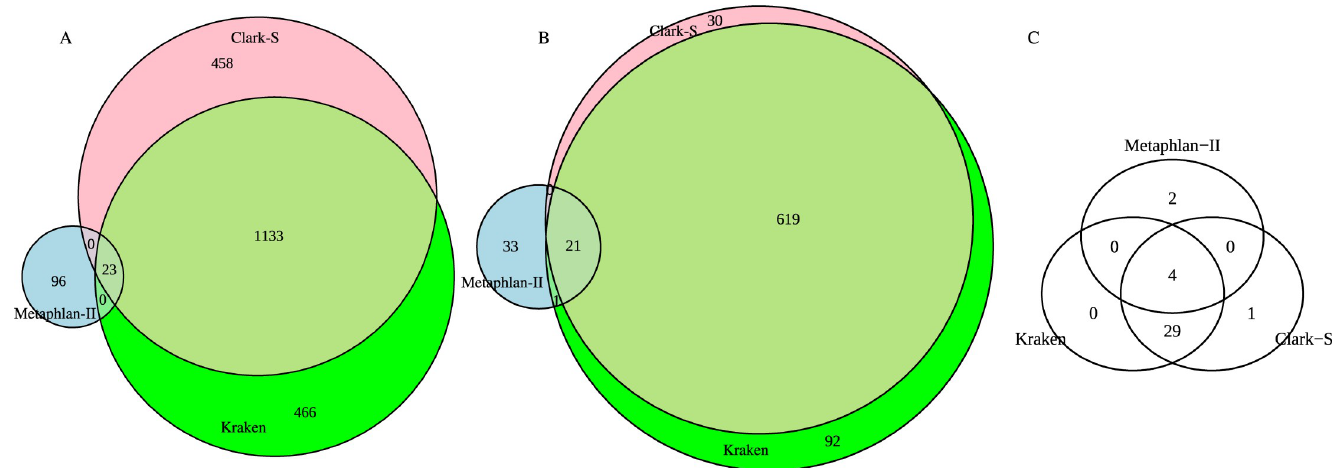
Fig 3. Taxonomical composition predicted for a fecal sample at full depth using 3 approaches. A . Abundance of reported species, ( B ) reported genera, and ( C ) reported phyla.